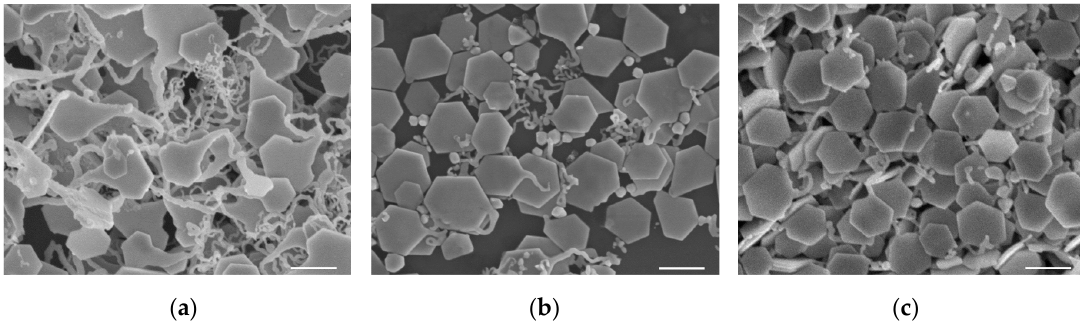
Figure 2. The SEM images of SNPs production under the same reaction conditions using 50 μ L sodium alginate (SA) during synthesis with different reaction durations: ( a ) 1, ( b ) 1.5, and ( c ) 2 h. The scale bar is 500 nm.